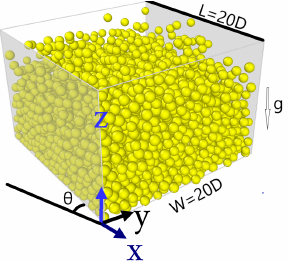
Figure 1: Flow geometry: The granular flow is confined by lateral walls with a width W = 20 D . Periodic bound- ary conditions are used in the stream-wise direction with a length L and an angle of inclination ✓